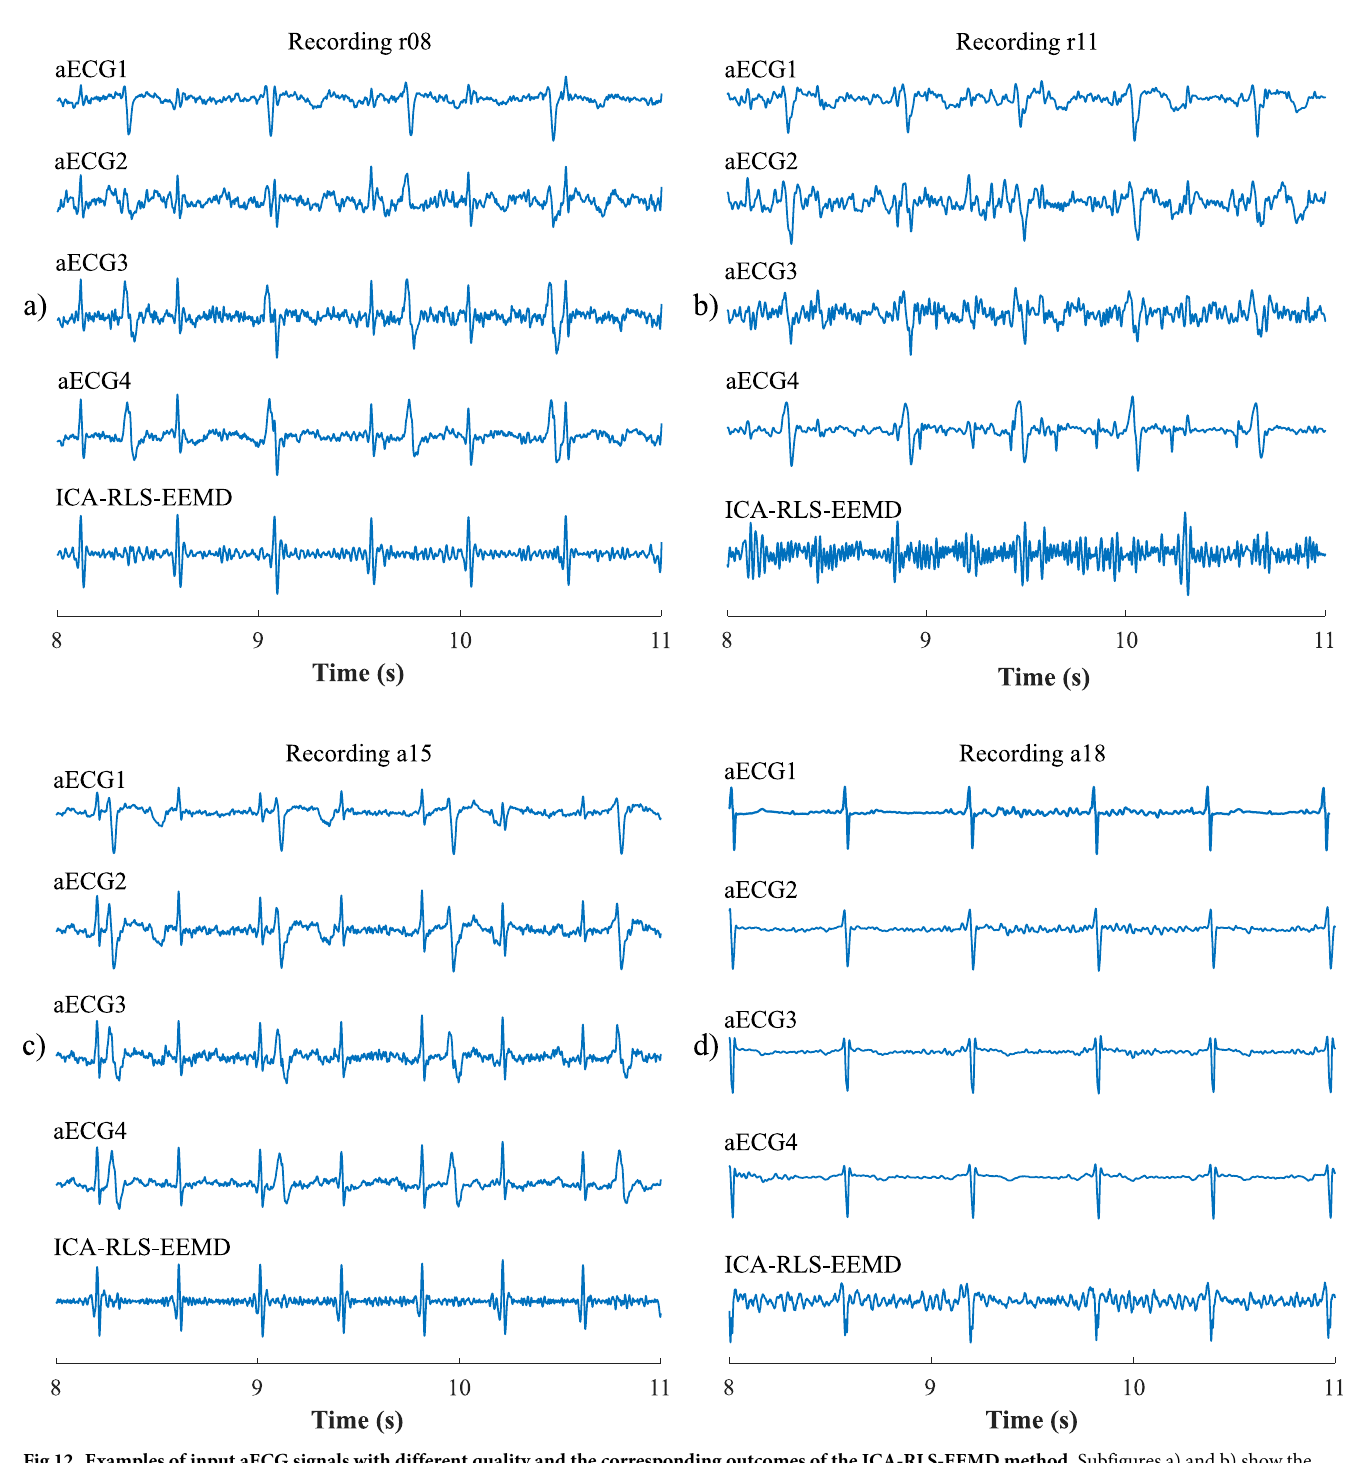
Fig 12. Examples of input aECG signals with different quality and the corresponding outcomes of the ICA-RLS-EEMD method. Subfigures a) and b) show the examples of the high- (r08) and low-quality (r11) recordings from the FECGDARHA database, for which, respectively, high and low accuracy of the ICA-RLS-EEMD extraction was noticed. Subfigures c) and d) show examples of high- (a15) and low-quality (a18) recordings from the Challenge database, from which fECG was and was not successfully extracted using the ICA-RLS-EEMD, respectively.